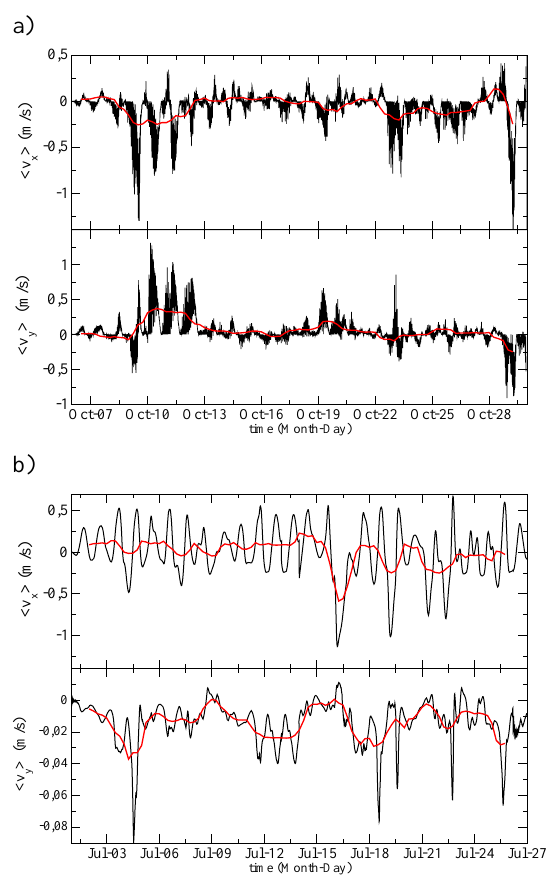
Fig. 2. (a) Complete time series throughout October of the zonal (top panel) and meridional (bottom panel) of the spatial average of the surface velocity field (black line). The red line is a running daily average. (b) Same as (a) but for July.